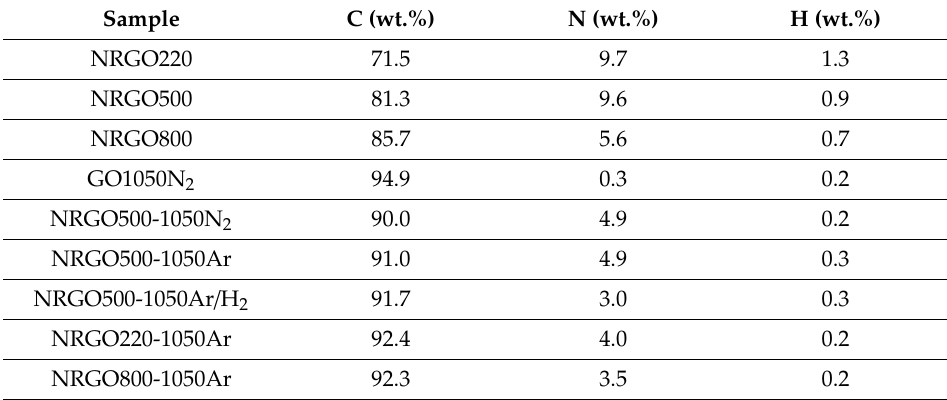
Table 2. Composition of C, N, and H (wt.%, determined by elemental analysis) present in GO and NRGO samples before and after annealing under N 2 , Ar, and Ar / H 2